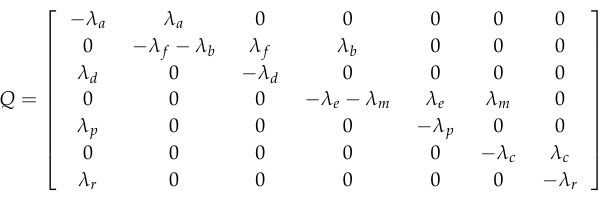
Figure 10. Defense Scenario II: the isomorphic model with the MC and the making process of SPN. The transition matrix Q